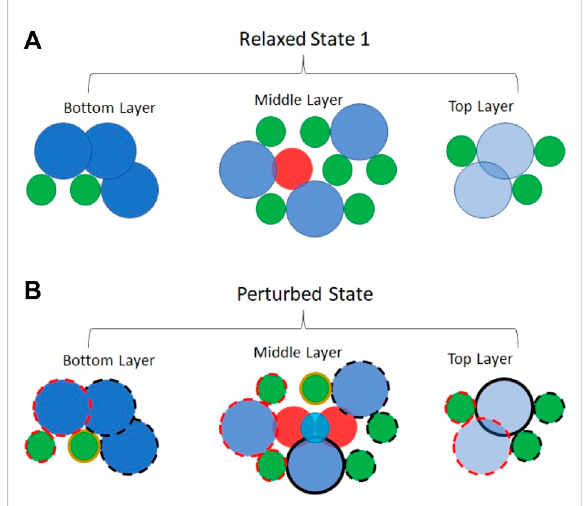
FIGURE 2 Molecular scale mixing of molecules within a ccp lattice of spacingequalto D n /1 . 5.Threelayersconsistingof5,10,or5lattice verticesareshown(upperpanel)Oneofthetwointeriorverticesof the control volume is vacant (red circle) while the other is occupied by the smaller (green circle) of two molecules. Each of the remaining vertices is fi lled at random (50/50) with a smaller or larger (blue circle) molecule (lower panel) Much like the upper panel except the interior molecule is shifted by ½ the lattice spacing toward the vacancy. Endothermic changes (bottom view to top view) are denoted with black borders. Exothermic changes are denoted by red or gold borders. The solid borders represent thefourinteractiontermsthataremostimportanttoviscosity.The dashed borders represent terms that are small in the perturbed